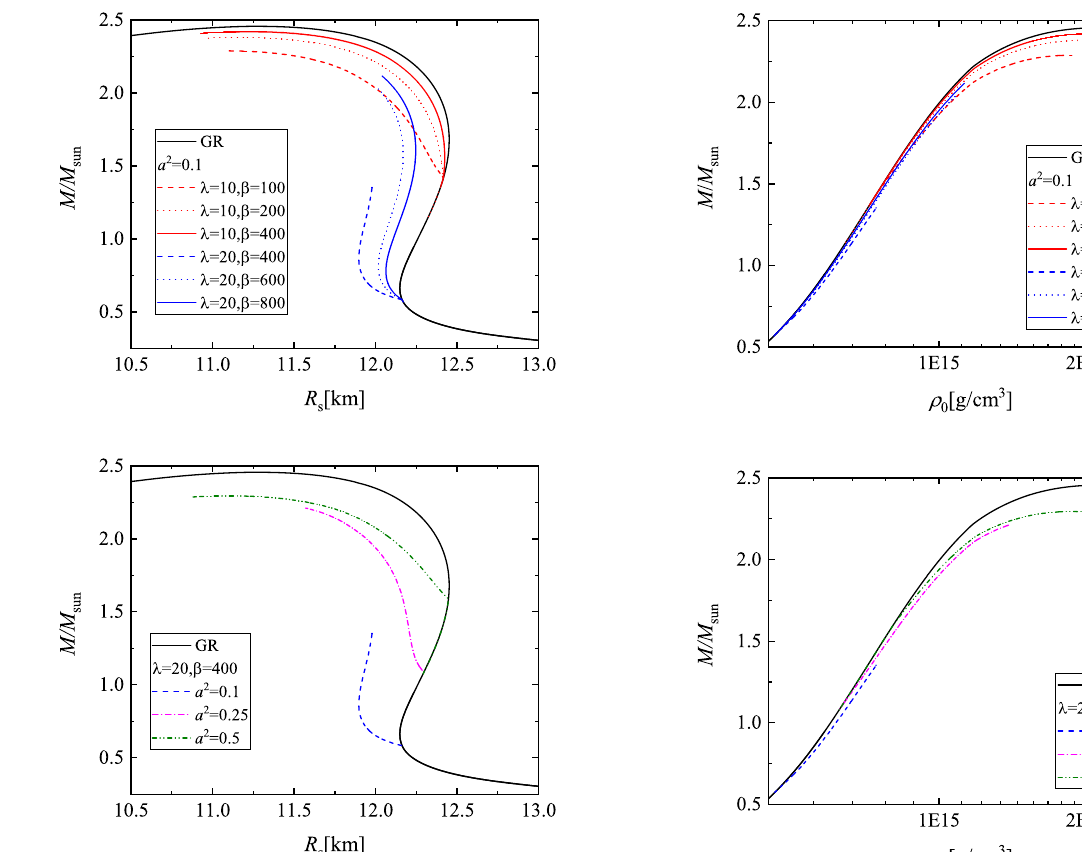
Fig. 2 Mass of the star as a function of the central energy density for models with different values of the parameters. Top: fixed value of a 2 and different values of λ and β . Bottom: fixed values of λ and β and different values of a 2 . The mass of the star is in solar masses and the energy density – in g / cm